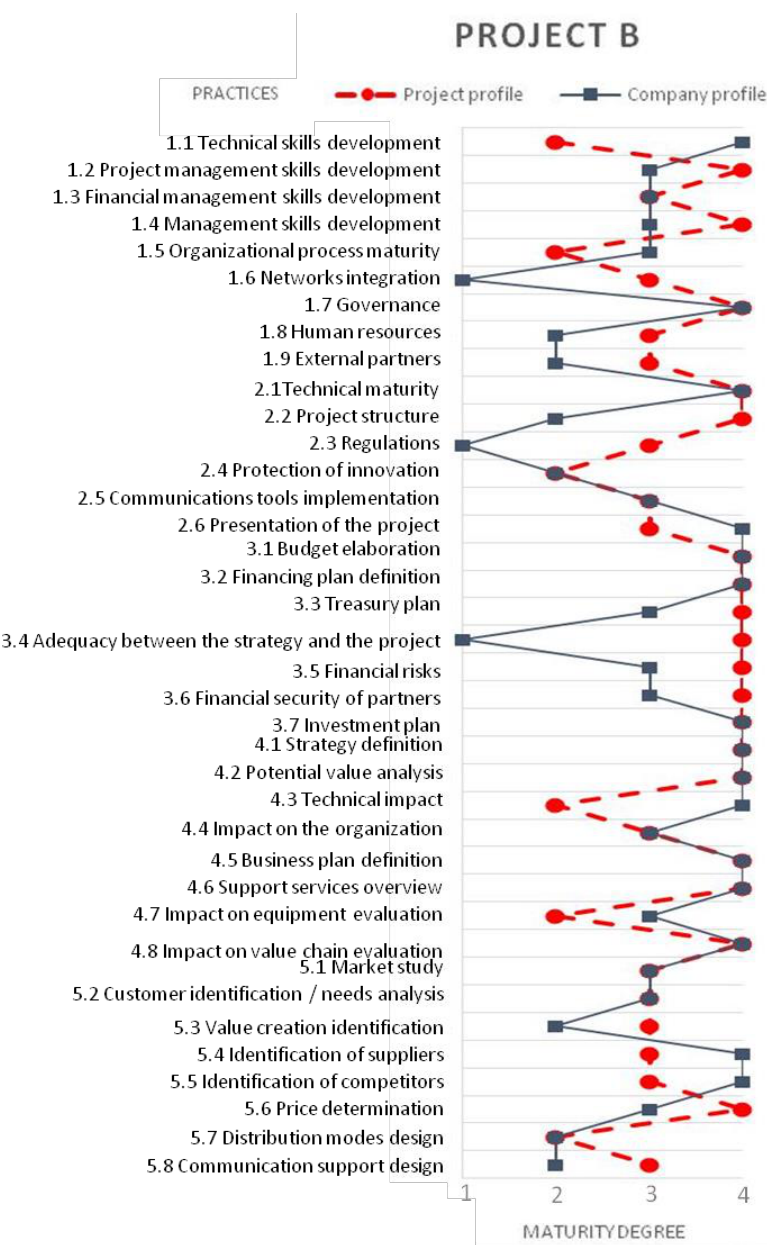
Figure 7. Comparison between the maturity profile of the company’s technology system and the profile required by project B.